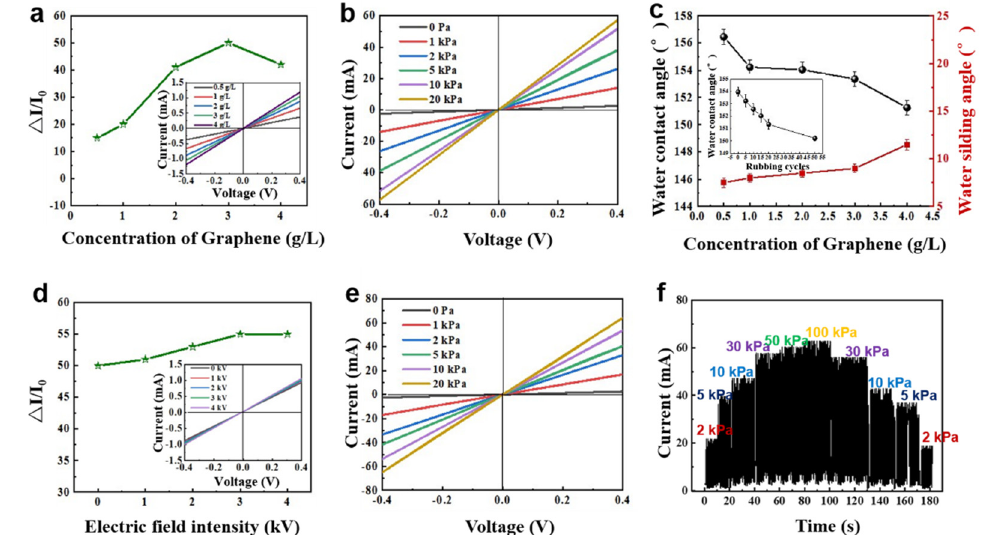
Figure 3. ( a ) ∆ I/I 0 value of the flexible pressure sensor at 50 kPa; the inset is the I − V curve of the single-layer fabric at different graphene concentrations. ( b ) I − V curves of the flexible pressure sensor under different static pressures. ( c ) Static and dynamic contact angles of the fabric after plasma treatment under different graphene concentrations; the inset shows the contact angle of the fabric after 50 rubbing cycles. ( d ) ∆ I/I 0 value of the flexible pressure sensor at 50 kPa after electric field induction; the inset is the I − V curve of the single-layer fabric under different electric field intensities. ( e ) I − V curves of the flexible pressure sensor under different static pressures after electric field induction. ( f ) Cycling test of the sensor under dynamic pressure after electric field induction.